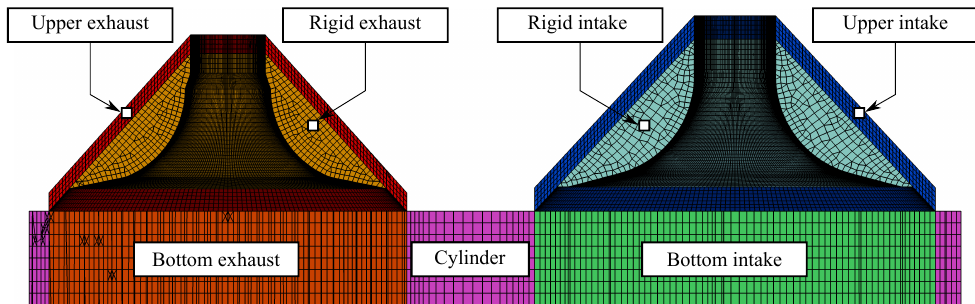
Figure 5. Description of the different zones used to solve the kinematics of the computational